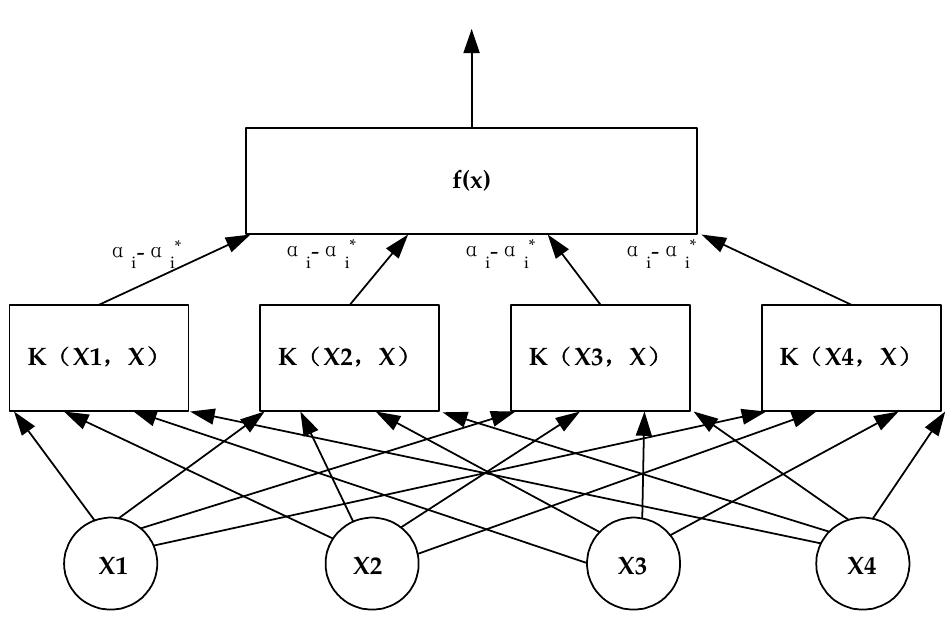
Figure 2. Structure of Support Vector Machine (SVM) model.